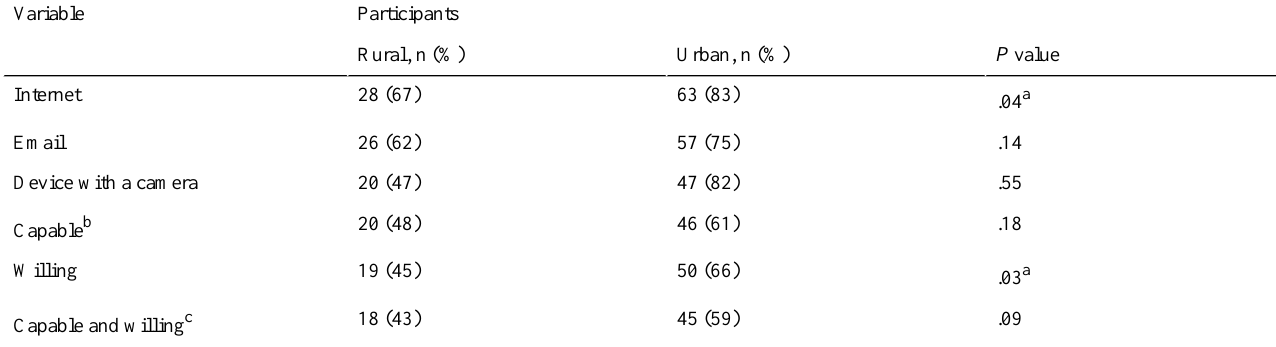
Table 3. Differences in the availability of various resources and capability and willingness among rural and urban